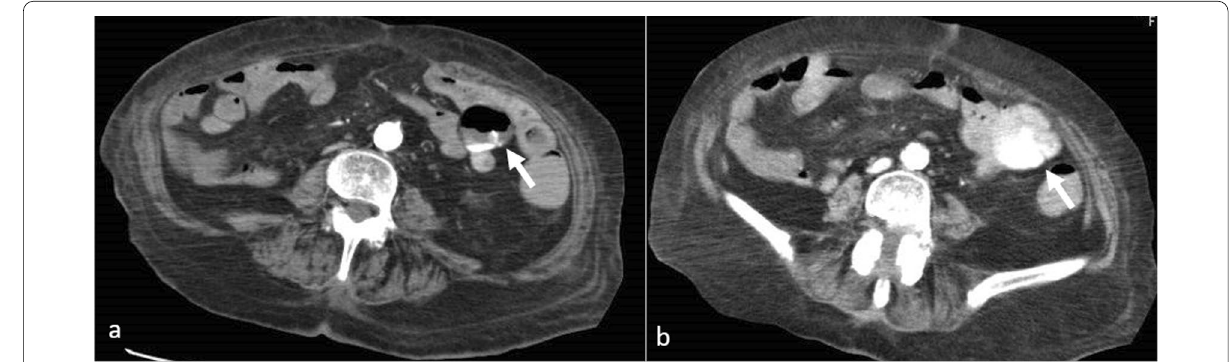
Fig. 1 Contrast-enhanced computed tomography of the abdomen. a Early phase. b Delayed phase. Arrow: extravasation around the upper